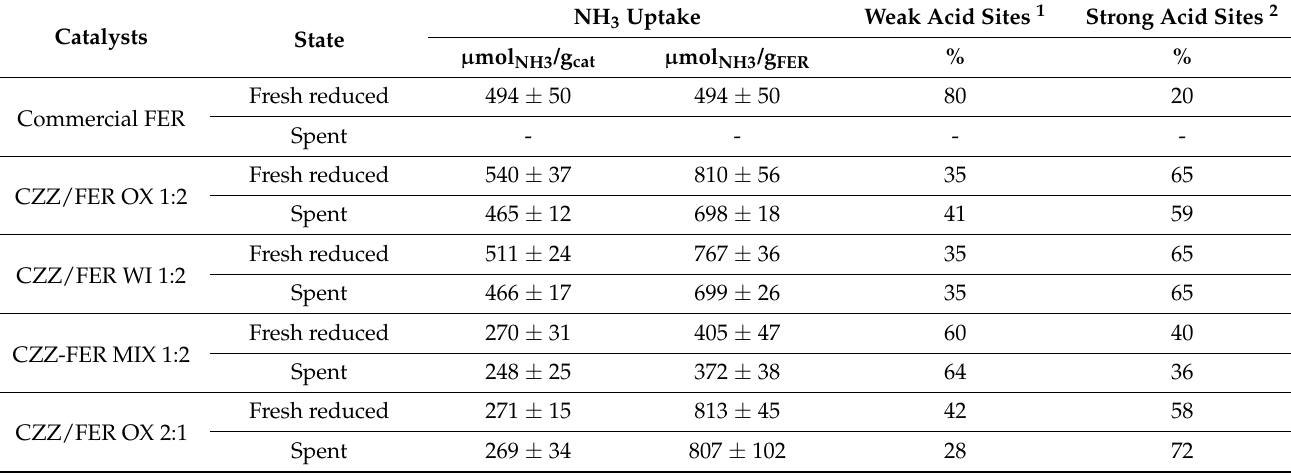
Table 2. Quantitative data of NH 3 -pulse